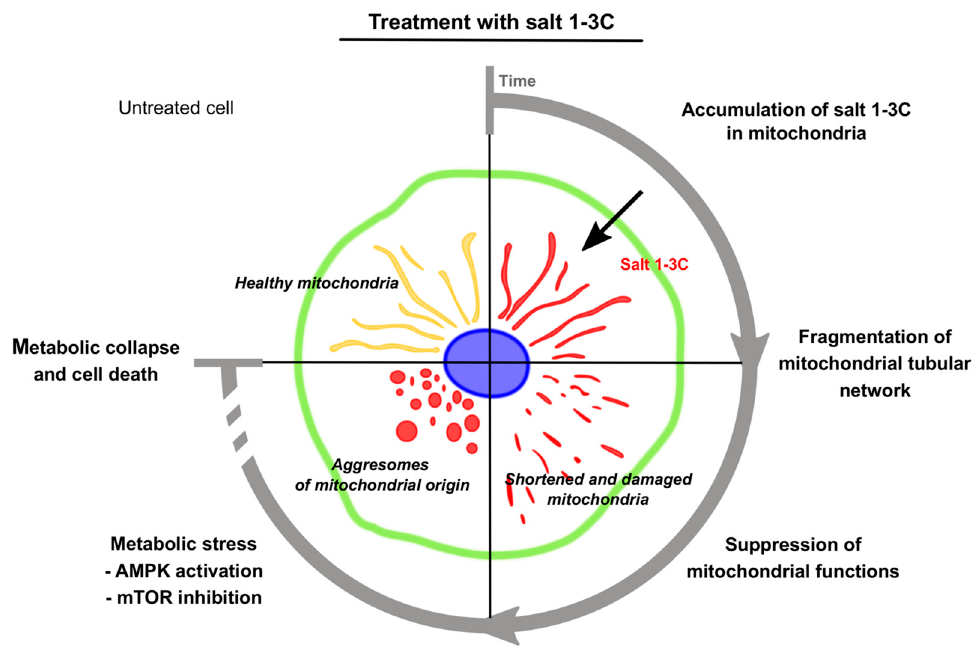
Figure 8. Mechanism of cytotoxic action of salt 1- 3C leading to metabolic collapse and cell death. Salt 1- 3C rapidly permeates cell membranes, accumulates in mitochondria, and induces mitochondrial fragmentation as early as 15 min after treatment, becoming more pronounced over time. Alterations of mitochondrial morphology are accompanied by suppression of oxygen consumption. Salt 1- 3C accumulates in aggresomes, implying an inability to fuse with lysosomes for destruction and recycling. Thus, salt 1- 3C disrupts mitophagic flux. Utilization of glucose for production of energy and for synthesis of metabolic intermediates increased. When glucose (or pyruvate) are depleted to a level incompatible with maintenance of basal metabolism, salt 1- 3C leads to overall metabolic collapse and cell death. mTOR = mammalian target of rapamycin.